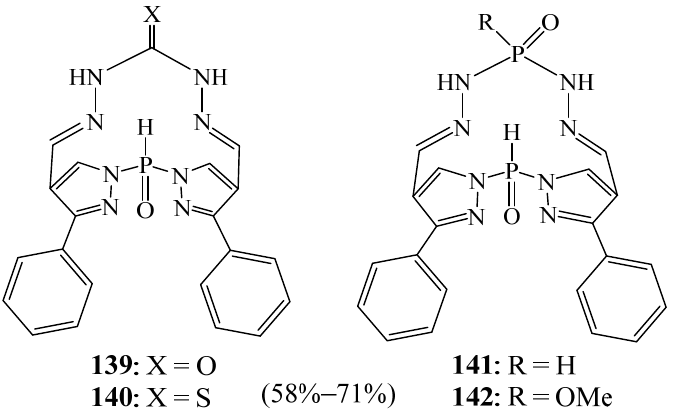
Figure 38. Phosphorus bipyrazolic macrocycles 139 − 142. (Reprinted with permission from ref. [60]. Copyright 2013 TÜB İ TAK).